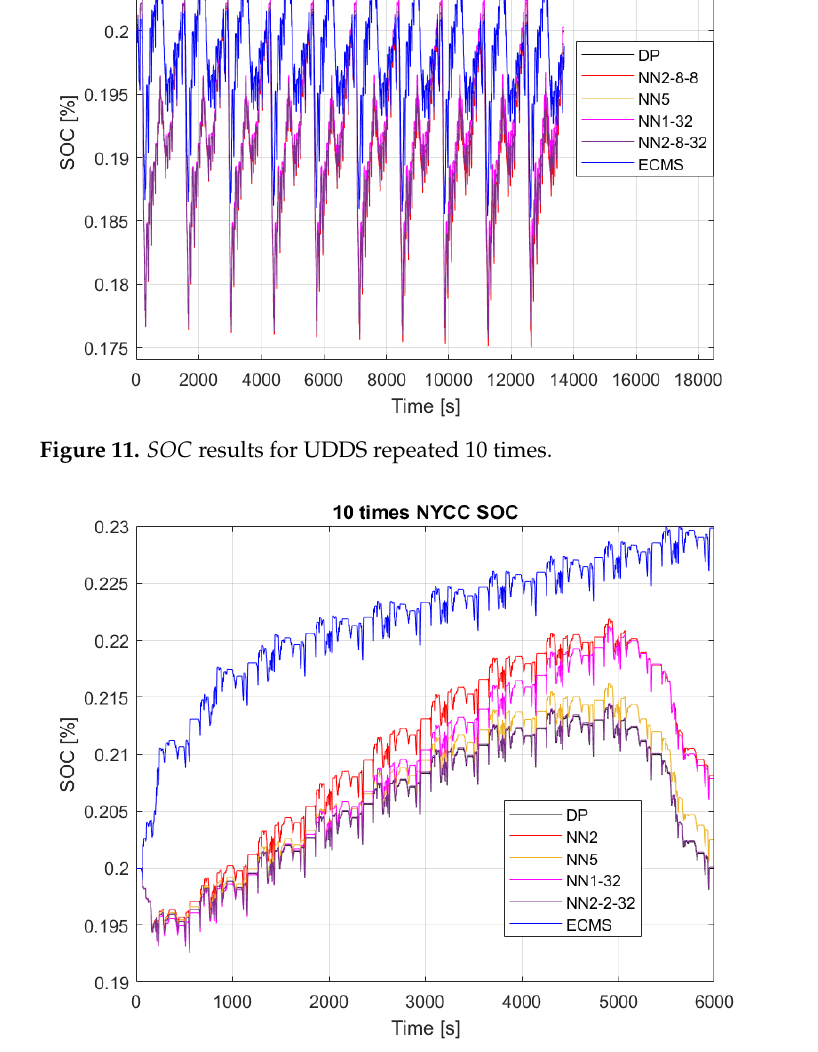
Figure 12. SOC results for NYCC-LD repeated 10 times. Table 6. Results comparison for UDDS repeated 10